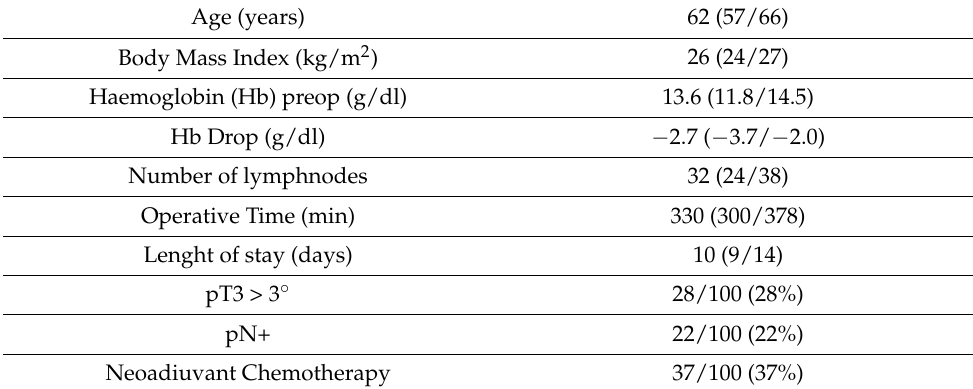
Table 1. Characteristics of the cohort.